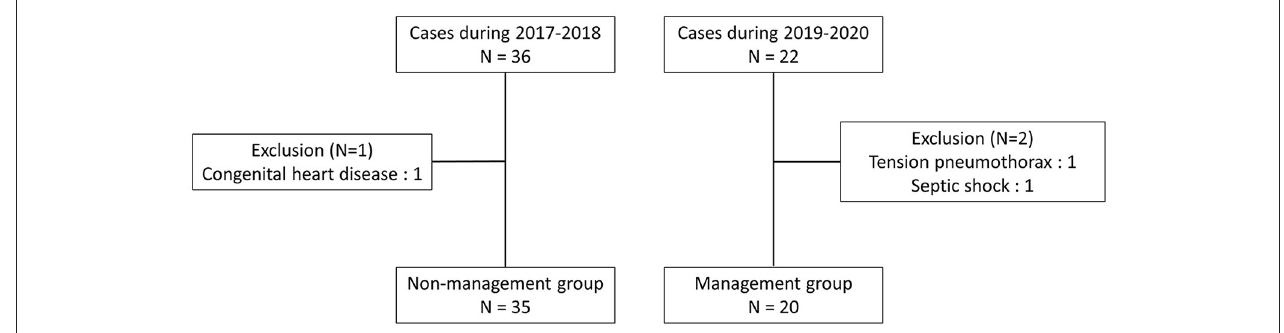
FIGURE 1 | The study flowchart of enrolled ELBW infants.